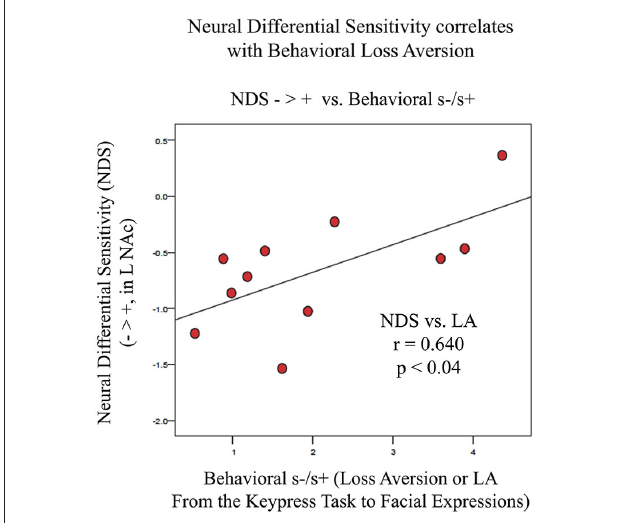
FIGURE 6 | Association between LA and NDS from BOLD signal collected by fMRI . NDS represents the difference between BOLD signal in the left VS/NAc for negative stimuli (Angry, Fearful, and Sad faces) minus positive stimuli (Happy faces). LA is represented as the absolute value of s-/s+ from the relative preference graphs of each subject as shown in Figure 3 . The line of best fit is shown from this association.